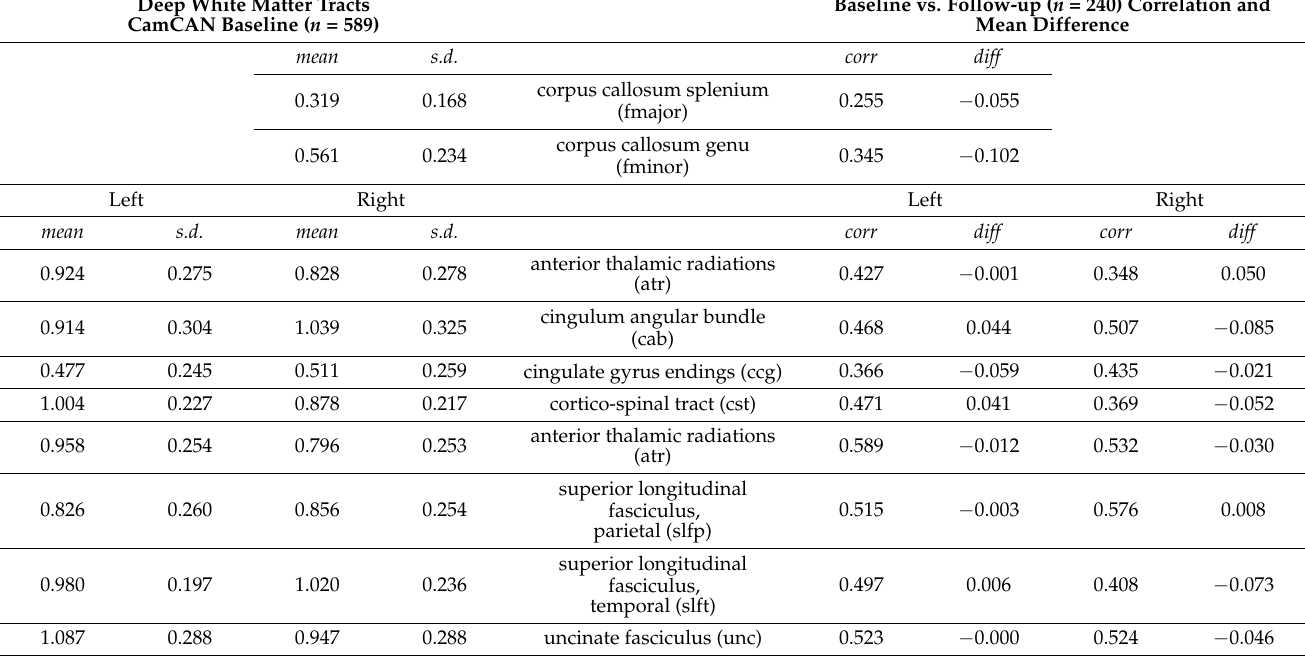
Table A1. Deep white matter tract traffic norms. Left columns—Atlas. The column labelled mean contains the normalized current density for the tract. s.d. == standard deviation . These were obtained from the CamCAN resting MEG recordings. A value greater/less than 1.0 indicates that normal tonic neuroelectric activity level for the tract is greater/less than that for the total volume of the brain. The activity measured within a tract for an individual is converted to a z-score using the corresponding mean and standard deviation listed in the table. Note that 589 of 619 CamCAN subjects had DWI scans; 240 returned for follow-up studies. Right columns—good test-retest reliability. The mean baseline to follow-up interval was 16.0 months. For each tract, the cohort-wide follow-up vs. baseline correlation ( Corr ) and difference ( Diff ) are shown. Diff is the mean z-score difference: follow-up–baseline. The correlations are all high and the differences are all low. Moderate significance (i.e., 0.03 > p > 0.002; − 3.0 < t < 3.0) is indicated with italics ; high significance (i.e., p < 0.002; t ≥ 3.0) is indicated in bold.